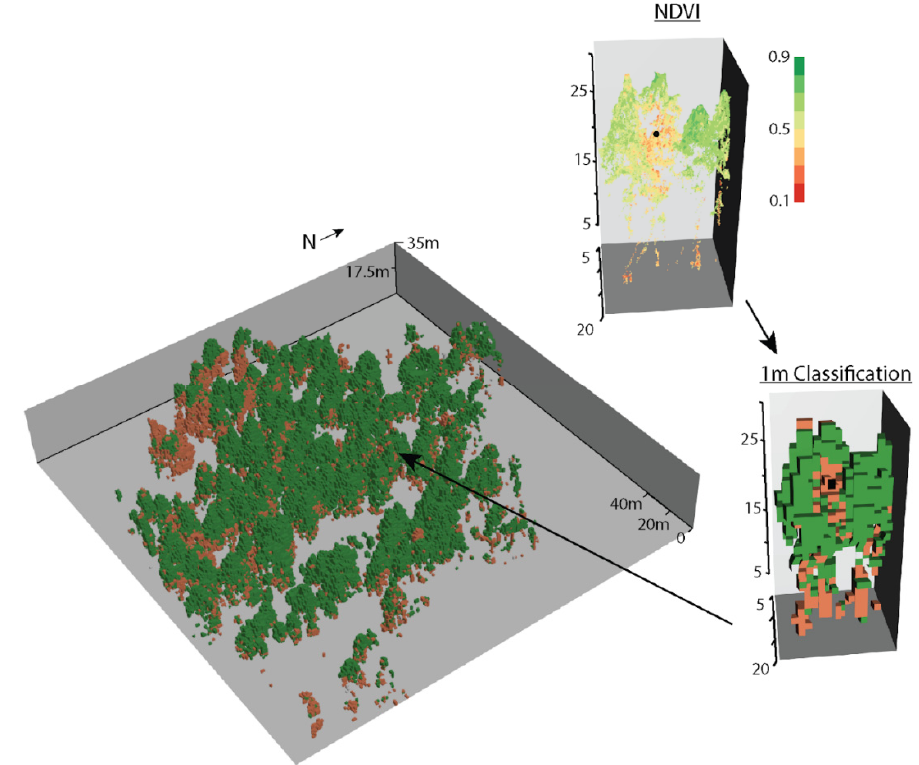
Figure 4. Example of a classification and voxelization method for mapping scorch using NDVI values of individual points. Voxels with >20% of points < 0.5 NDVI were classified as scorched (red voxels). Following classification, 20.3% of the canopy voxels in the study area were considered scorched. The black point in the two insets was the location of the field-estimated scorch height measured using laser hypsometers and survey-grade GPS systems. Only points and voxels > 2 m in height above ground are shown.